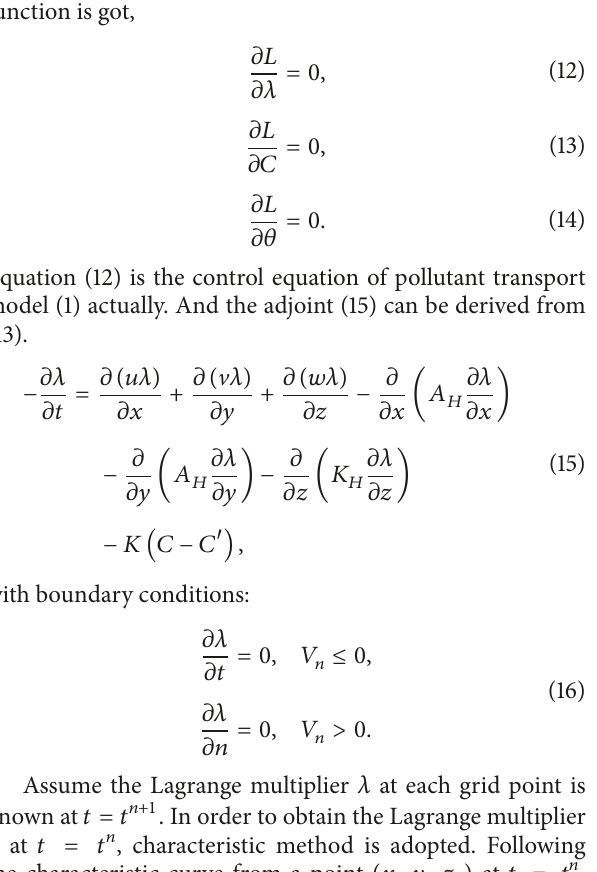
indicate grid steps. 𝑘+1/2